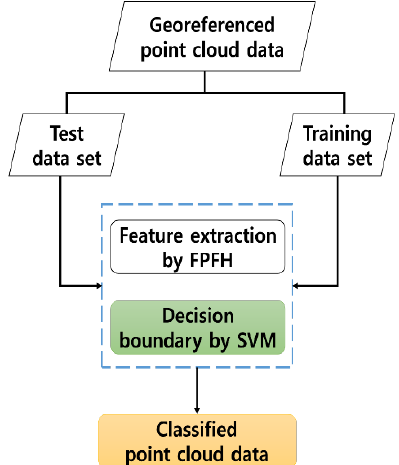
Figure 2. A flow chart about our approach